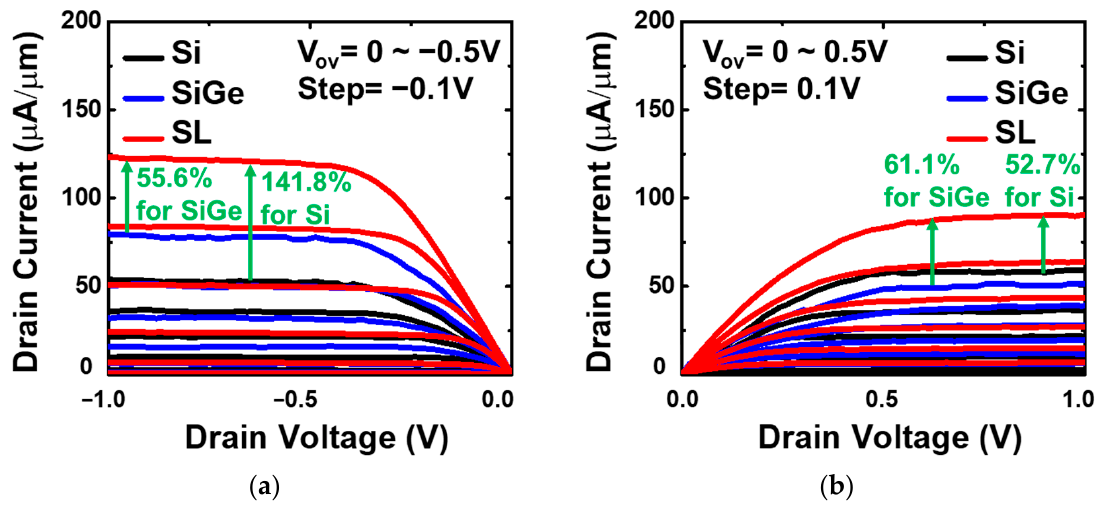
Figure 9. I D -V D characteristics of ( a ) P-type Si 0.8 Ge 0.2 /Si SL, Si 0.8 Ge 0.2 , and Si FinFET and ( b ) N-type Si 0.8 Ge 0.2 /Si SL, Si 0.8 Ge 0.2 , and Si FinFET with L G = 200 nm and F W = 30 nm.